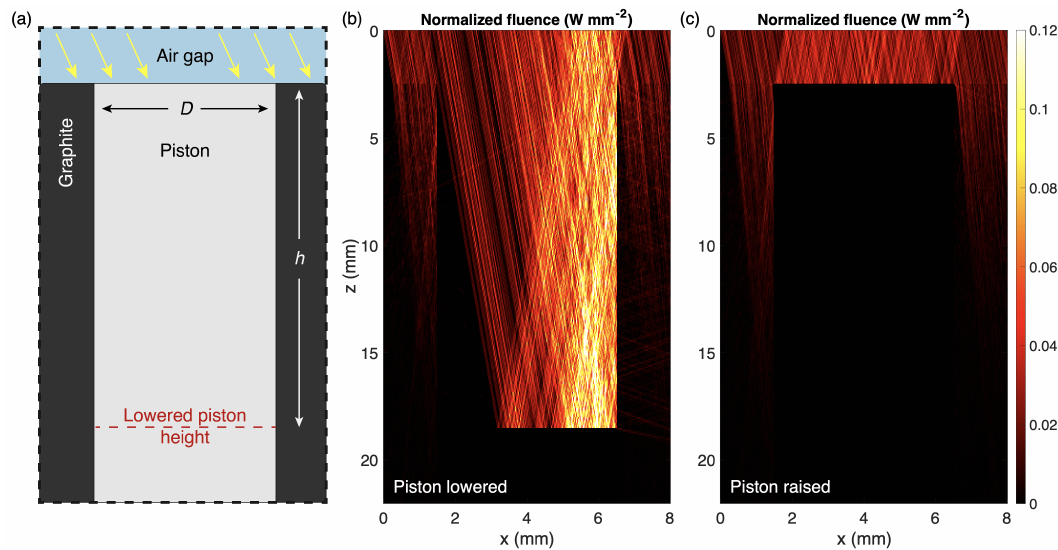
Figure 3. Monte Carlo simulation of tunable piston device. ( a ) Schematic of simulation control volume (cross section), illustrating the simulated geometry. The control volume measures 8 mm × 8 mm × 24 mm. The lowered piston displacement h is 16 mm, piston diameter D is 5.0 mm, and the air gap is 2.5 mm. The source is a 550 nm plane wave with an angle of incidence of 6 ◦ . Fluence results for ( b ) lowered and ( c ) raised piston structures, taken at the center cross section of the device (y = 4